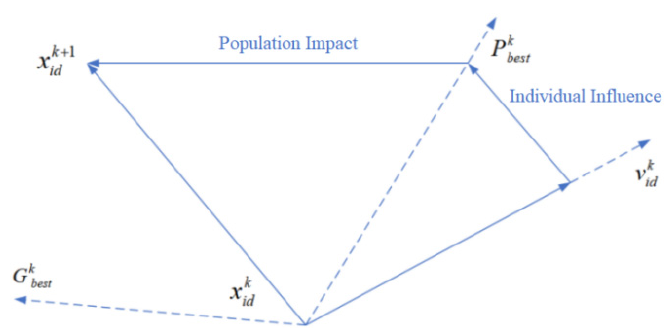
Figure 6. Schematic diagram of particle displacement.